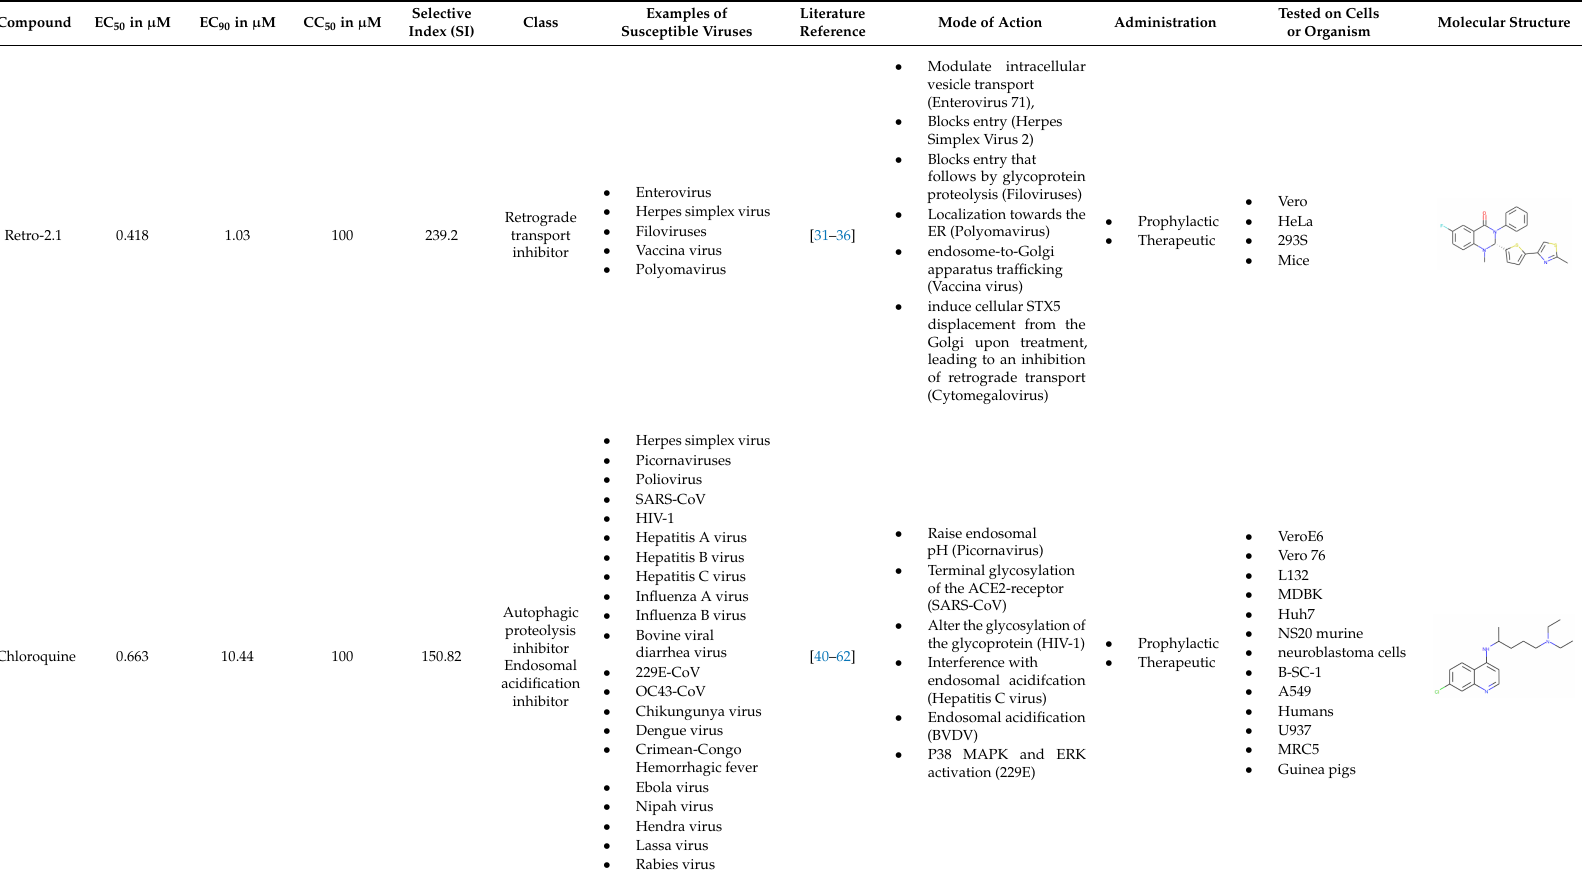
Table A2. The EC 50, EC 90 and CC 50 values of the five compounds that showed inhibition of SARS-CoV-2 during the compound dilution series on VeroE6-cells, including references to the mode of action of these compounds against other viruses. Remdesivir is included as a reference drug control. Abbreviations: N.D.: not